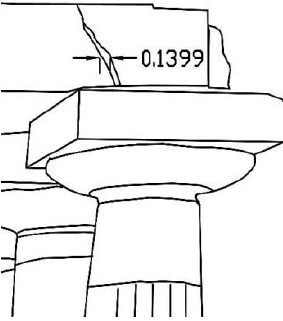
Figura 10. Particular of a fracture of Hera Argiva’s Temple